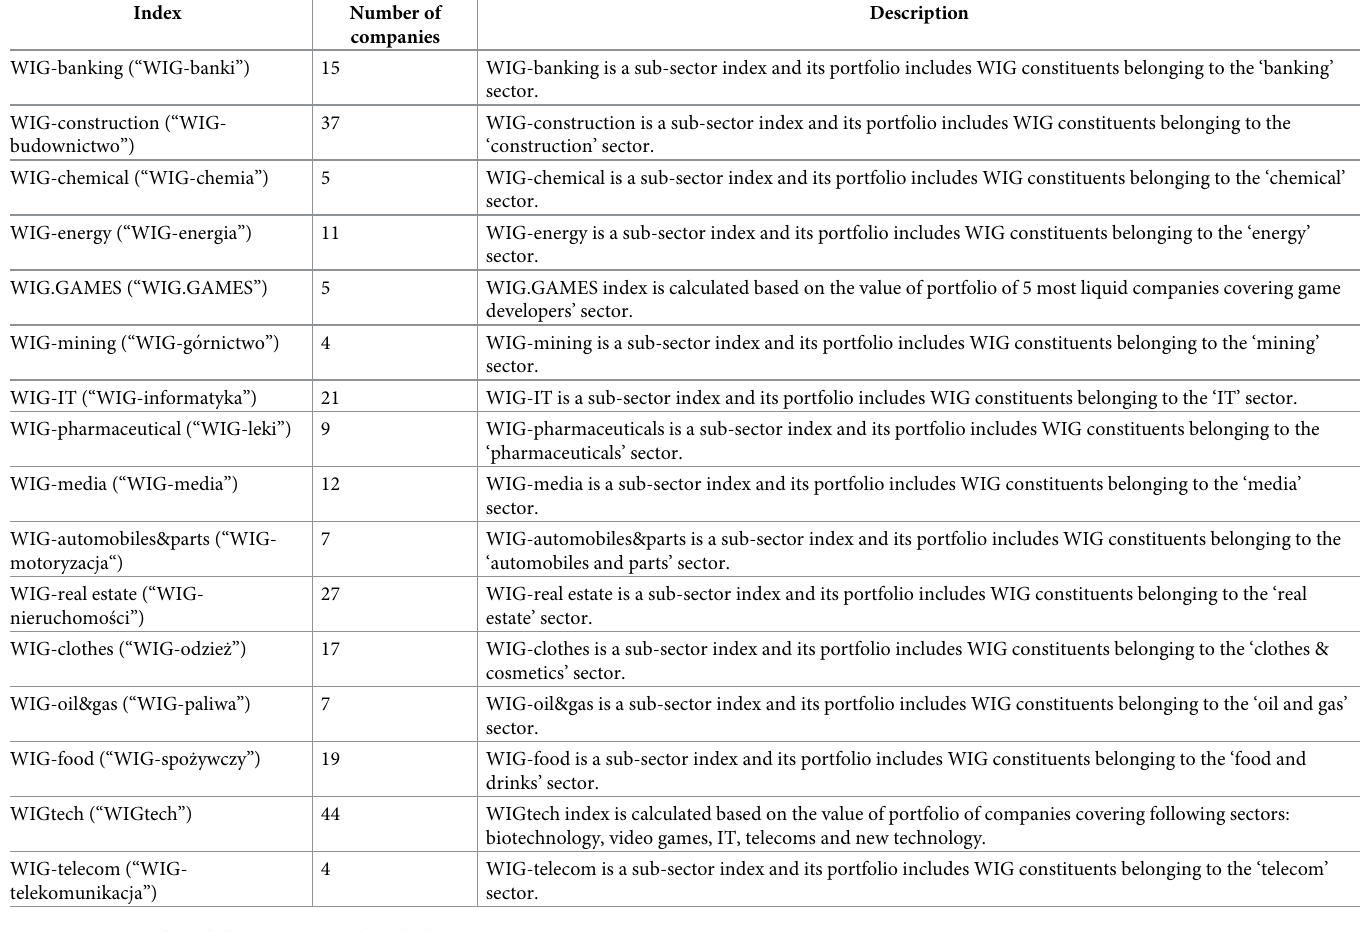
Table 1. Description of investigated